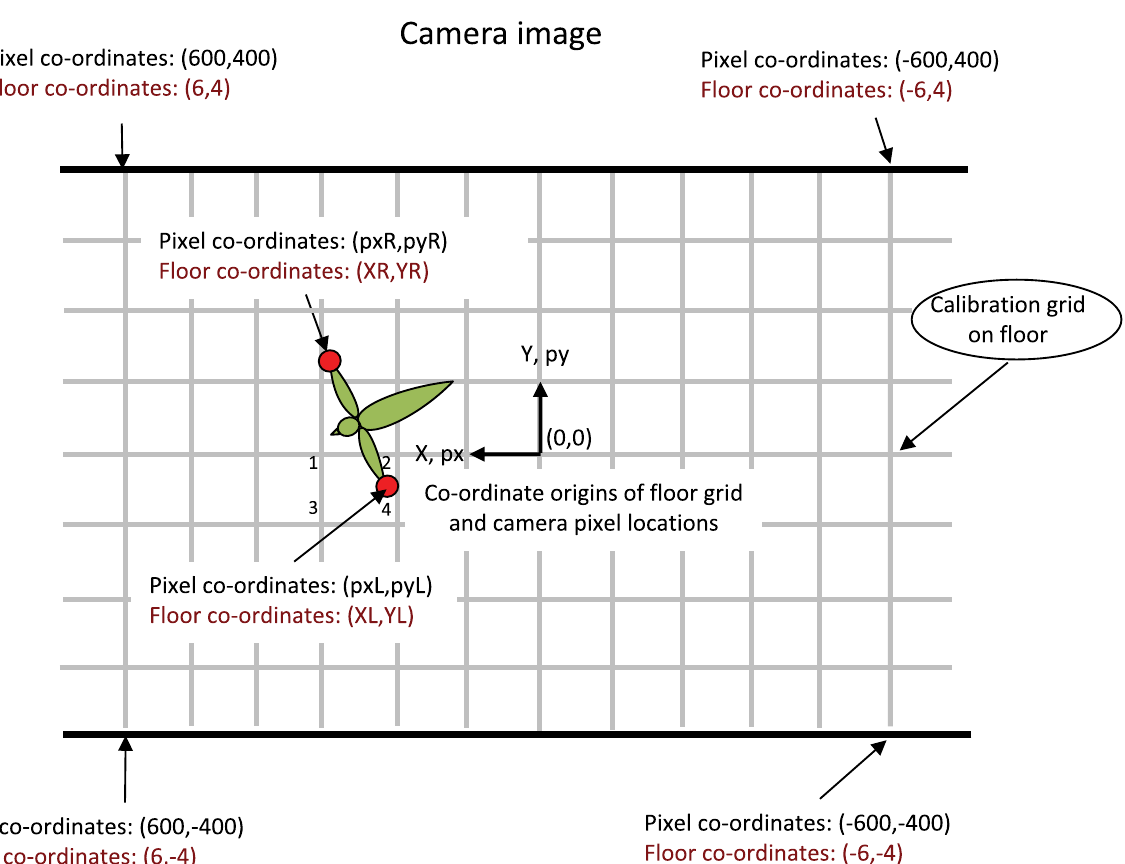
Fig 1. Schematic view of image of the flight chamber. The view is from an overhead video camera, showing the calibration grid on the floor, and the instantaneous position of a bird with its wings extended. The origin of the pixel co-ordinates is taken to be the center of the image, i.e., corresponding to the direction of the camera’s optic axis. The origin of the calibration grid is taken to be the point directly beneath the camera, i.e., the position where the optic axis of the camera intersects the floor.